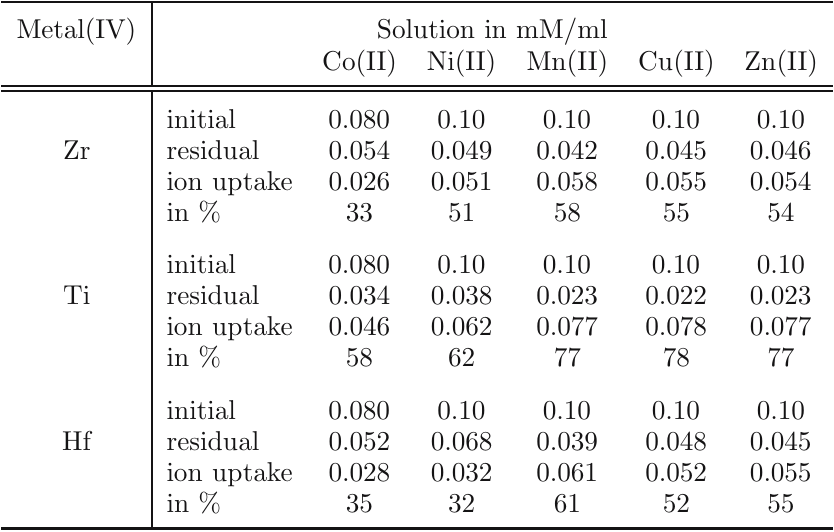
Table 1 Analytical data of samples equilibrated during 200